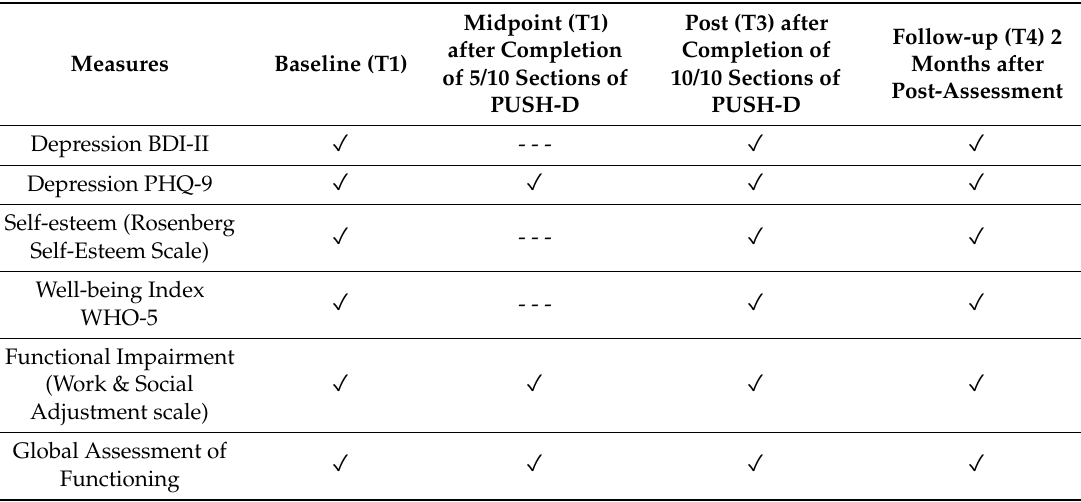
Table 2. Measures used during the pilot trial of PUSH-D. Table 3. Summary of the discussed control techniques. Table 3. Summary of the discussed control techniques. Table 3. Summary of the discussed control techniques. Table 3. Summary of the discussed control techniques. Table 3. Summary of the discussed control techniques. Table 3. Summary of the discussed control techniques. Table 3. Summary of the discussed control techniques. Table 3. Summary of the discussed control techniques. Table 3. Summary of the discussed control techniques. Table 3. Summary of the discussed control techniques. Table 3. Summary of the discussed control techniques. Table 3. Summary of the discussed control techniques. Table 3. Summary of the discussed control techniques.